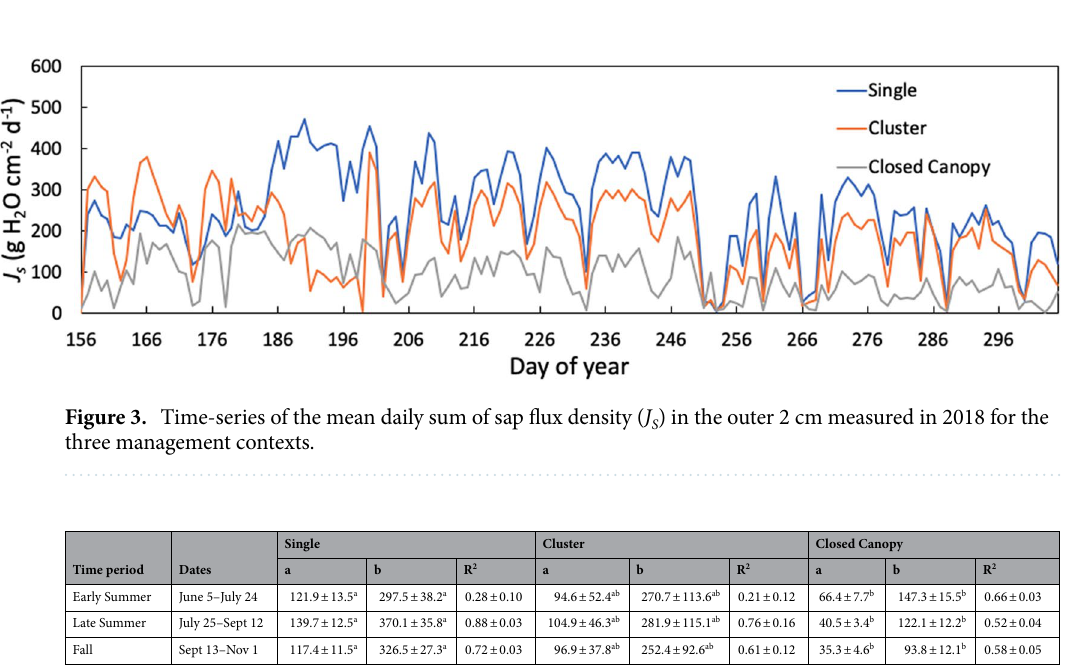
Figure 2. Box plots of the daily sum of sap flux density ( J S ) across the three management contexts. Unique letters above boxes indicate a significant difference among treatments based on post hoc analysis. (Figure created using R software version 4.0.5 65 ).